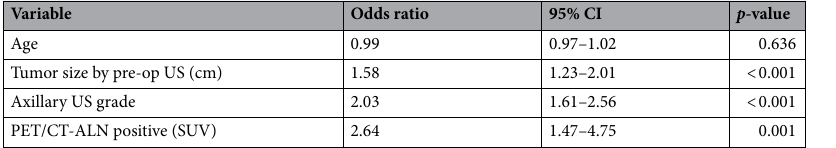
Table 3. Multivariate logistic regression analysis for factors associated with involvement of three or more axillary lymph nodes. ALN , Axillary lymph node; CI , Confidence interval; US , Ultrasonography; PET/CT , Positron emission tomography/computed